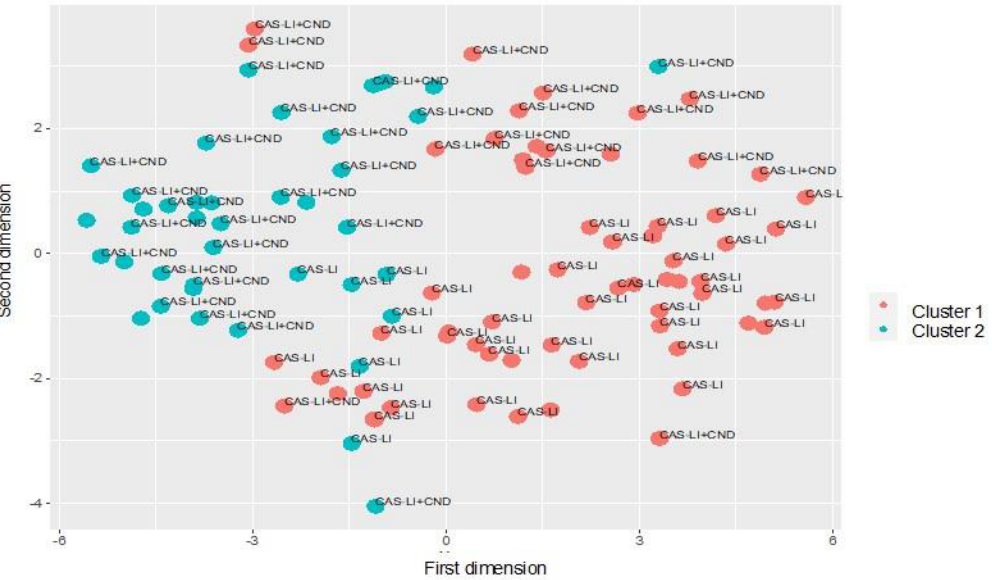
Figure 1. Representation of participants on a bidimensional space according to cluster membership. Each point represents a participant involved in the study. The points are colored according to cluster membership and labelled according to the clinical classification. The distribution of the points suggests that the children belonging to the same cluster are mostly located in the same area. On the other hand, the analysis also reveals a high degree of overlap between the clusters and the clinical classification. Table 4. Cluster analysis: distribution in relation to the clinical subgroups and to the assessed